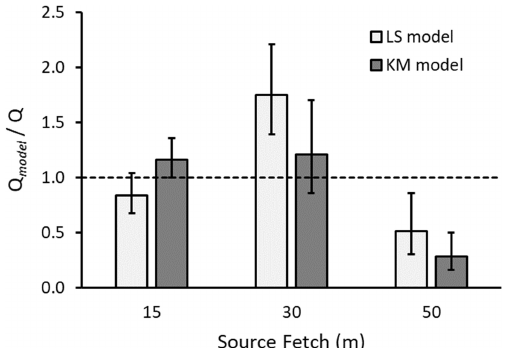
Figure 2. Agreement ratio of the footprint-model-calculated emis- sion rate ( Q model ) to actual release rate ( Q ), grouped by source fetch of 15m ( n = 26), 30m ( n = 9), and 50m ( n = 24). Calcu- lations are from the LS and KM models. The columns show the geometric mean, and the error bars show the 95% confidence inter- val of the mean. The dashed horizontal line represents a Q model /Q ratio of 1, or a perfect model calculation.